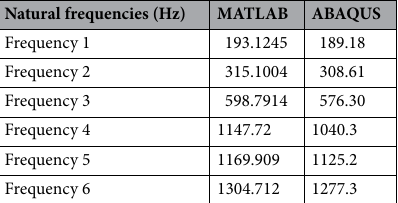
Table 2. The first six natural frequencies of the FDM model obtained through MATLAB codes, and ABAQUS.